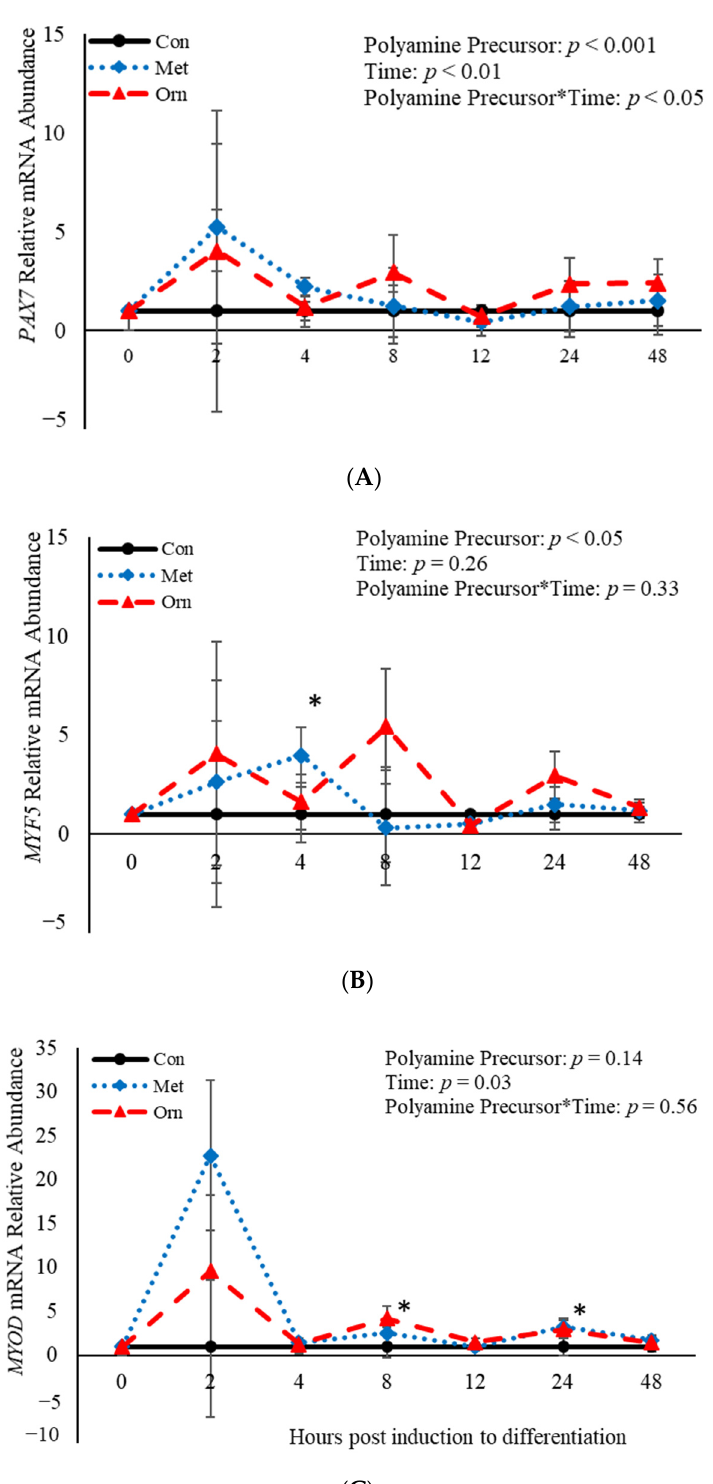
Figure 4. Relative mRNA abundance of paired box transcription factor 7 ( PAX7 ; ( A ), myogenic factor 5 (MYF5; ( B ), and myogenic differentiation factor 1 (MYOD ; ( C ) from primary bovine satellite cells cultures following treatment with 10 mM methionine (MET) or 8 mM ornithine (ORN). Cultures were grown to 80% confluency and treated with DMEM/3% horse serum and 10 mM MET or 8 mM ORN. Abundance was measured 0, 2, 4, 8, 12, 24 and 48 h after treatment, as described in the Materials and Methods. The main effects of polyamine precursor, time and polyamine precursor*time in mRNA abundance were analyzed as repeated-measures. Data represent relative mRNA abundance normalized against 18S abundance and are presented as LS mean ± SEM from six separate replicates utilizing BSCs isolated from at least three different animals. Differences ( p < 0.05) between polyamine precursors and the control cultures are indi- cated by a * at that particular time point.